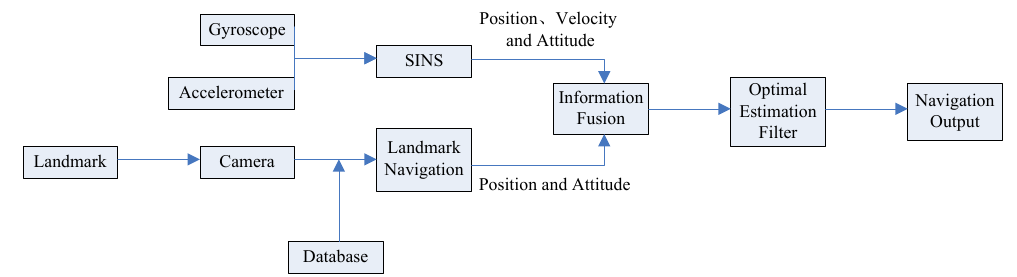
Figure 4. Process of the SINS/Landmark integrated